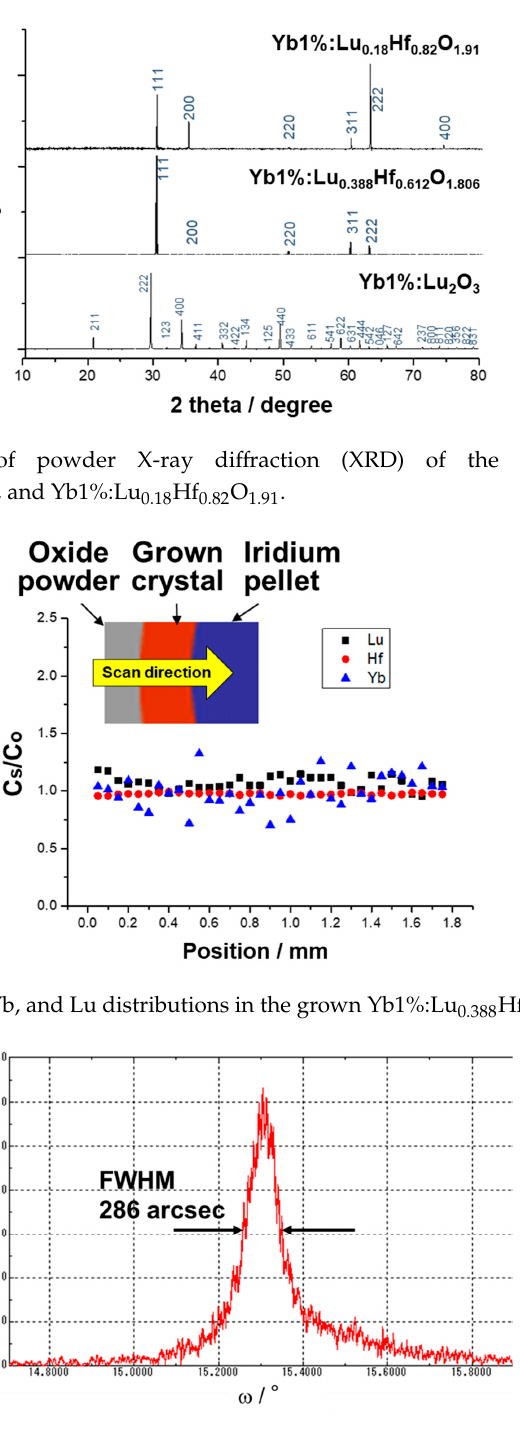
Figure 6. X-ray rocking curve (XRC) of the CH-grown Yb1%:Lu 2 O 3 sample. (2 θ = 29.66° <2 2 2>, slit size: 0.5 mm × 0.5 mm). Cu K α (40 kV, 30 mA). slit size: 0.5 mm × 0.5 mm). Cu K α (40 kV, 30